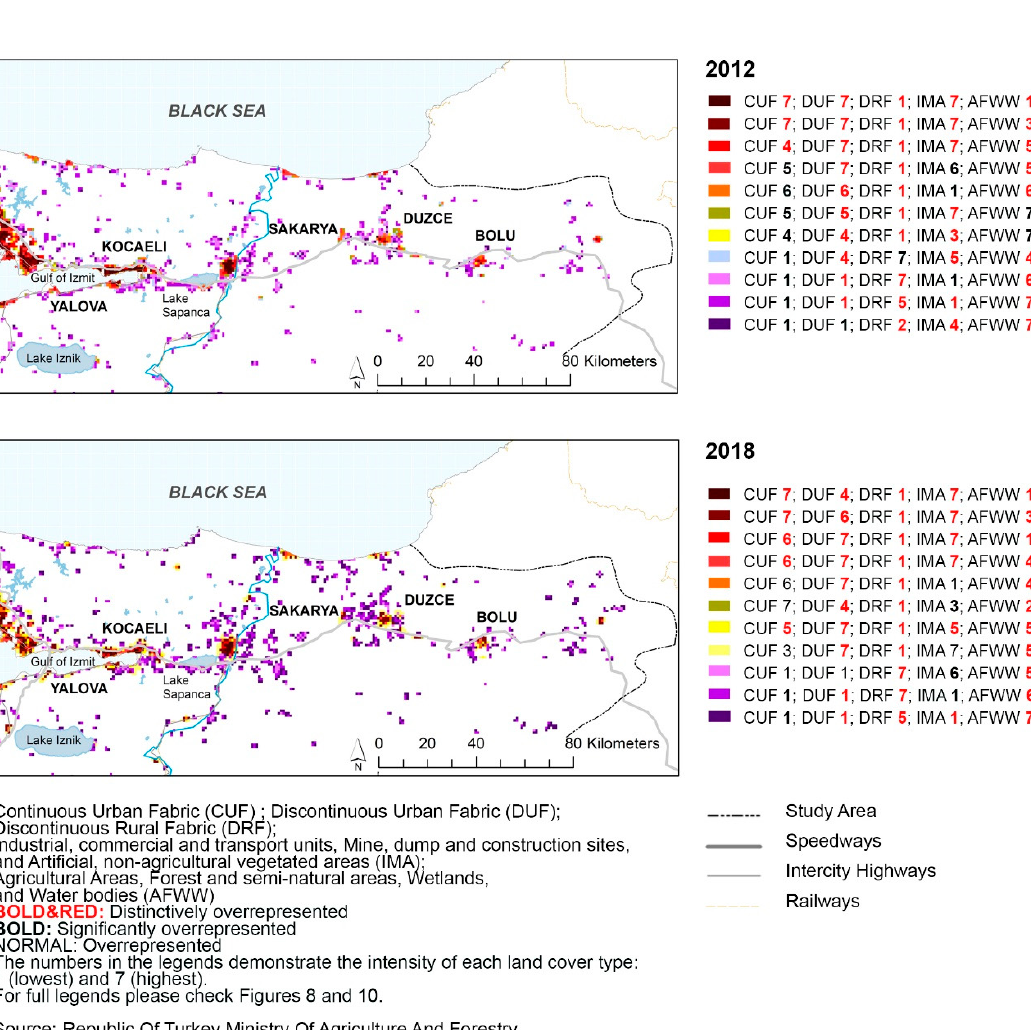
Figure 11. Urban fabric land cover comparison of the eastern Marmara axis for 2012 and 2018.